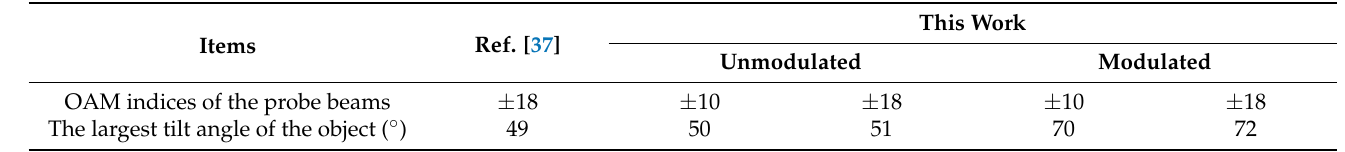
Table 1. Comparison of previously published works with this work on the rotating velocimetry of a tilted object using OAM light